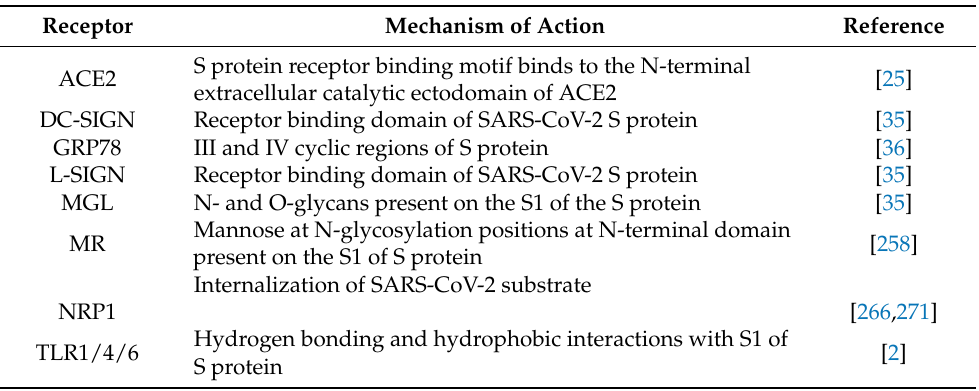
Table 1. Potential novel viral entry points through direct binding of SARS-CoV-2 spike protein and their corresponding mechanism of action during SARS-CoV-2 recognition. Receptor Mechanism of